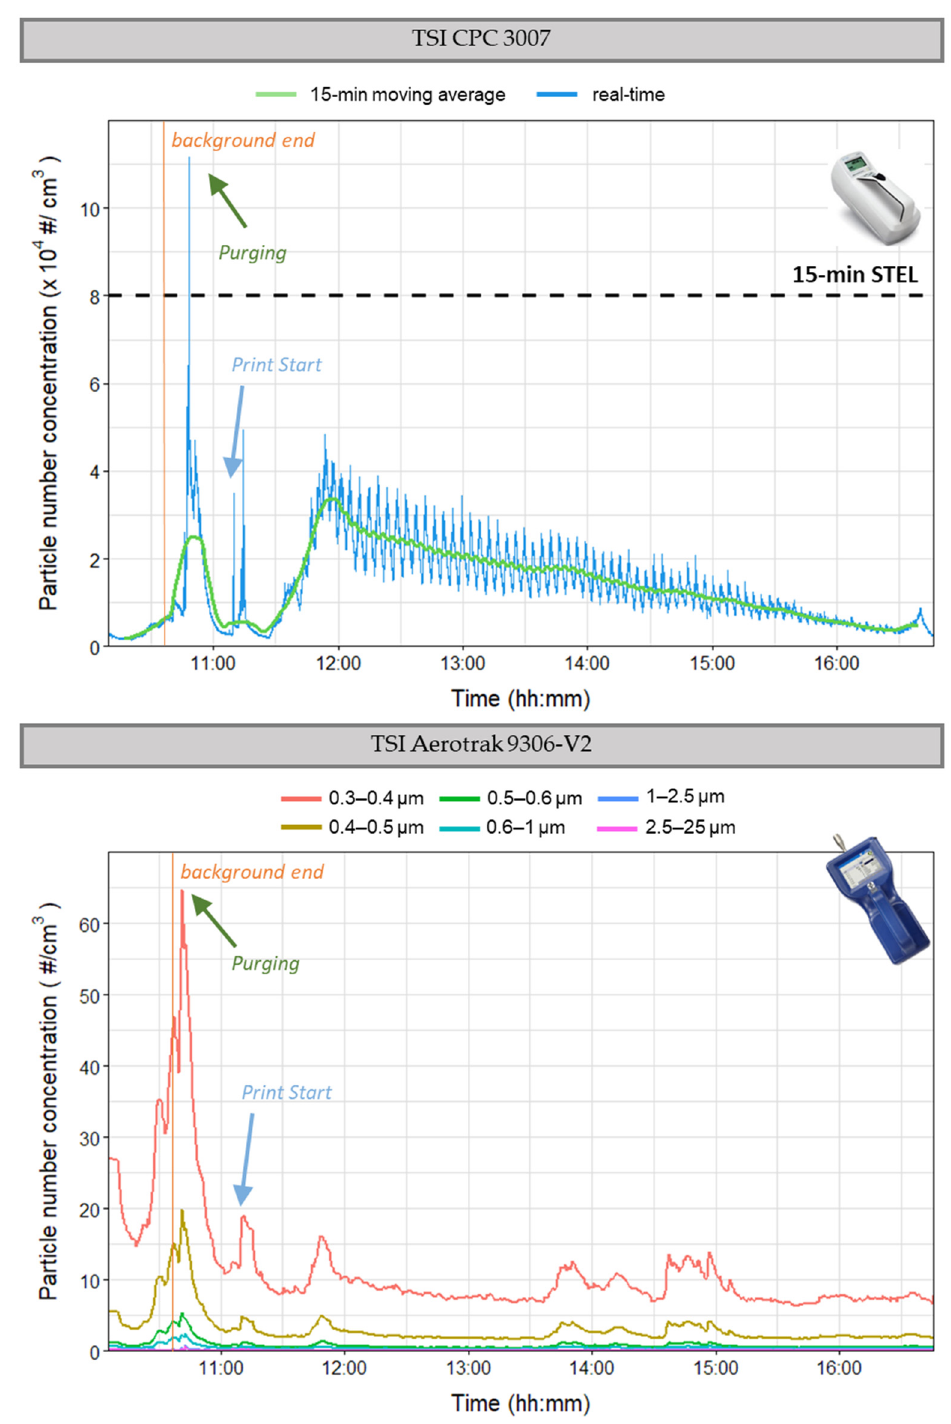
Figure 5. Particle concentrations for Case 3b.